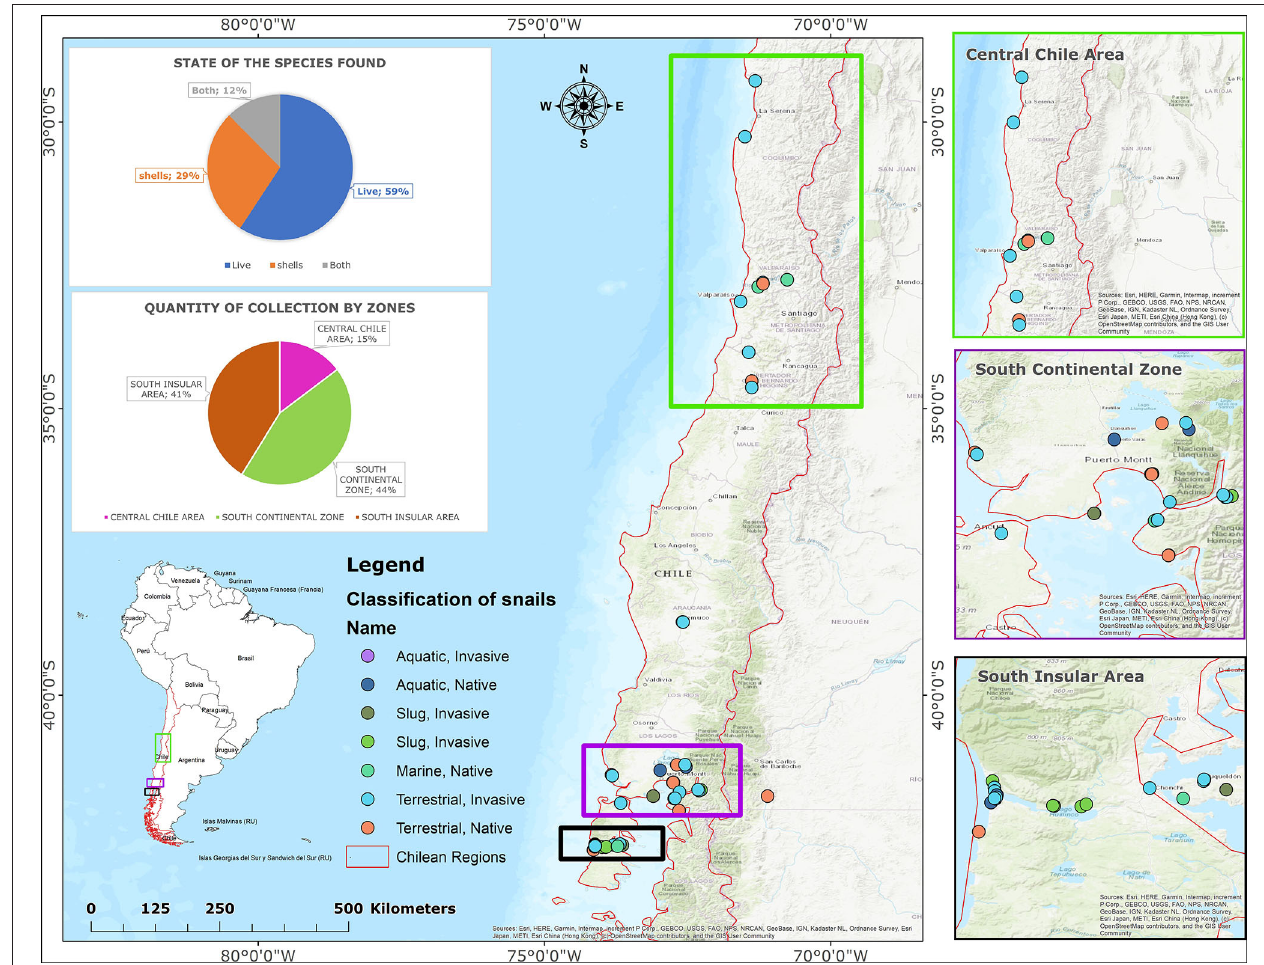
FIGURE 2 | Location of snails collection in Chile (Elaborated by Paulina